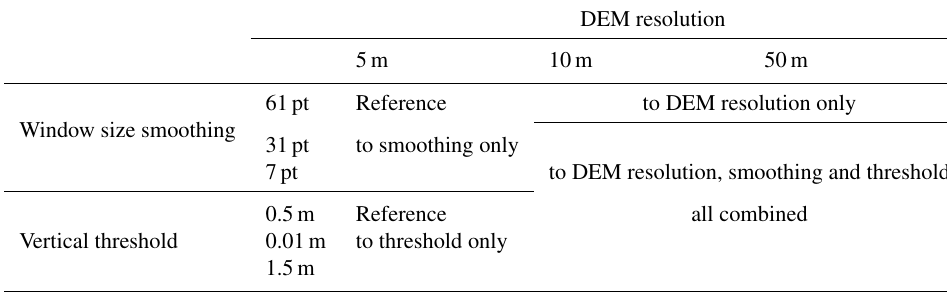
Table 2. Summary of the local sensitivity analysis of cliff toe and top locations to different model